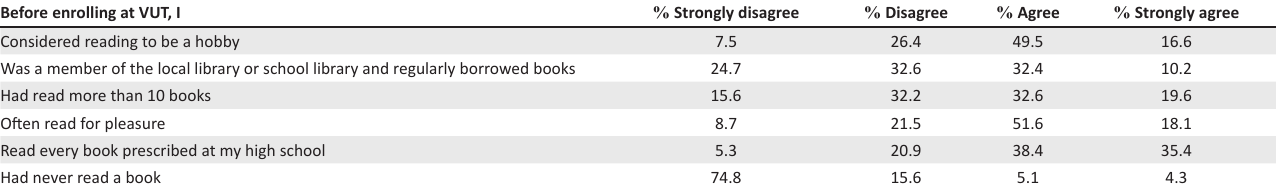
TABLE 3: Personal reading habits. Before enrolling at VUT, I